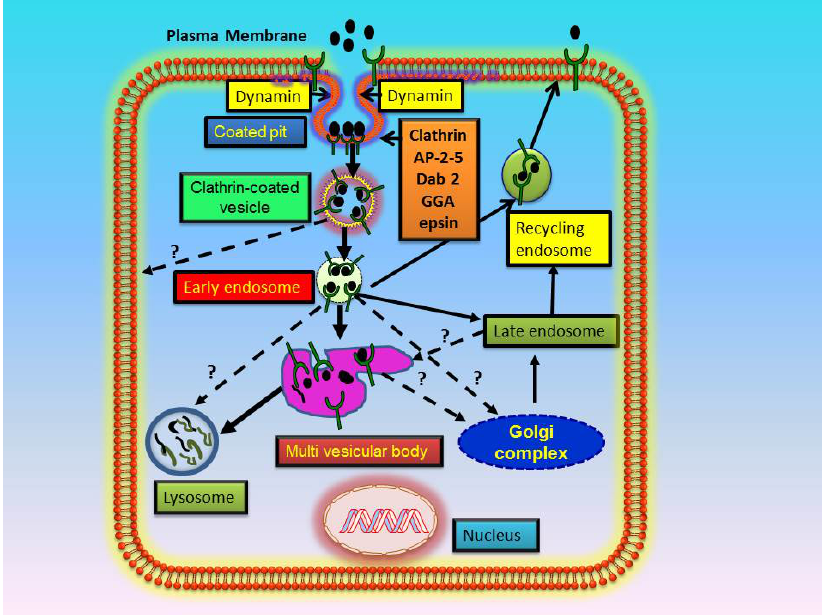
Figure 2. Schematic representation of ligand-mediated receptor endocytosis and trafficking pathways: Ligand-binding to cell surface receptors leads to a selective recruitment of ligand-receptor complexes (cargo) into clathrin-coated pits. The coated pit represents a small area of the plasma membrane, which invaginates and pinches off into vesicles in the cytoplasmic compartments. The coated vesicles trigger the recruitment of APs for example AP-1, AP-2, AP-3, AP-4, and AP-5 as well as other interacting protein molecules such as disabled-2 (Dab-2) and Golgi-localizing gamma adaptor homology domain binding protein (GGA). The clathrin-dependent routes require dynamin to achieve the fission of membrane invaginations and subsequent internalization of vesicle into the cell interior. The ligand-receptor complexes within the vesicles entering via clathrin pathway are usually directed to early endosomes. Within the endosomes, ligand-receptor complexes are sorted and directed to various subcellular compartments, where the internalized receptors are either routed to degradative compartments such as late endosomes, multi vascular bodies, and/or lysosomes, or recycled back to the plasma membrane via recycling endosomes. Alternatively, the internalized cargo may be sequestered in endosomes for a longer period of time and continue to spark signaling events. Some early and late endosomes also contain membrane structures in the lumen, which are referred to as multi-vesicular bodies (MVBs). The endosomes and lysosomes can also transmit and receive cargo from trans-Golgi network (TGN) involving vesicular intermediate carriers. The key proteins involved in the trafficking of molecules at different locations may include: AP-1, AP-2, AP-3, AP-4, AP-5, Dab-2, and